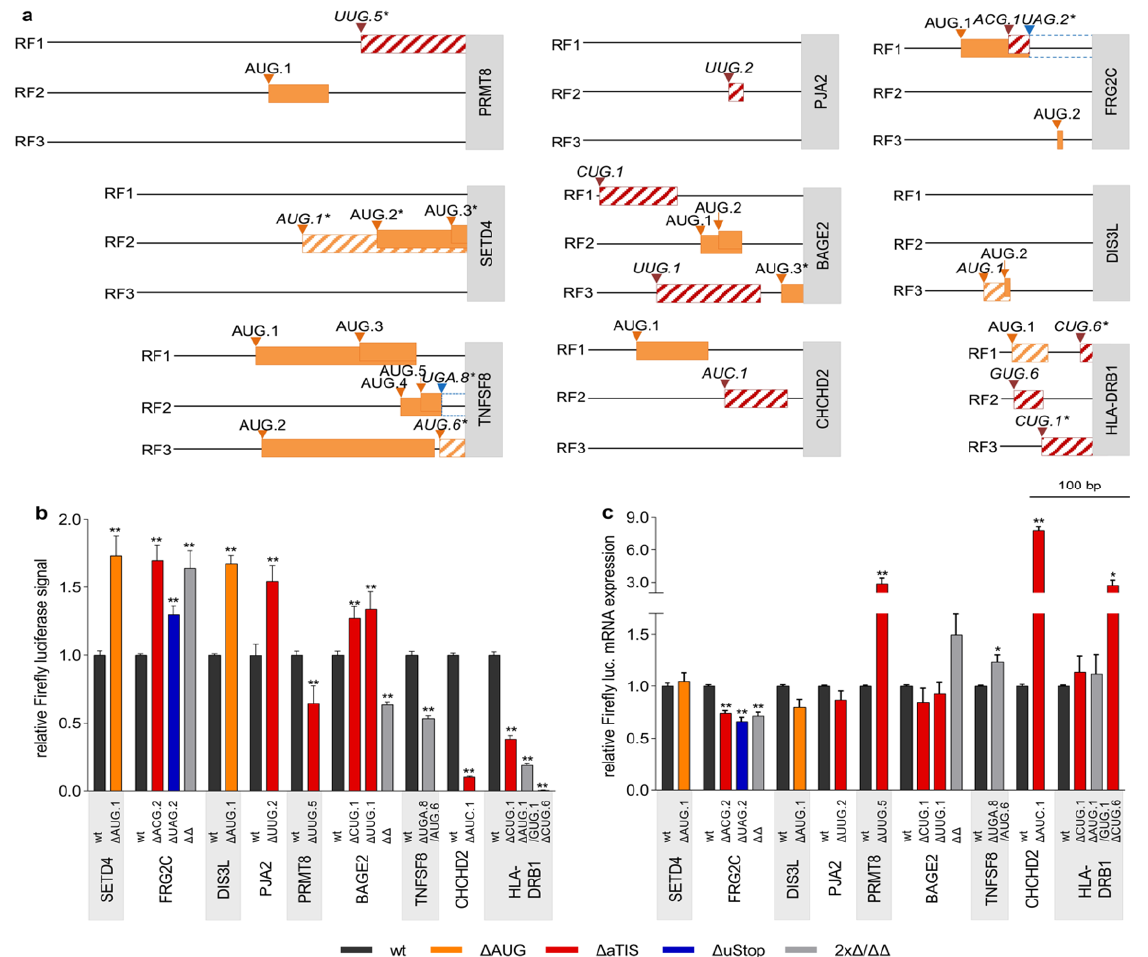
Figure 3. Naturally occurring cancer-associated genetic uORF variants alter downstream translational regulation. ( a ) Schematic representation of indicated TLSs, displaying the position, length and reading frame (RF, black lines) of uAUG (boxes with oblique orange lines) and aTIS (boxes with oblique red lines) uORFs affected by recurrent somatic SNVs. The start of the CDS is depicted by grey boxes containing the respective gene symbol. The lengthening of uORFs due to uStop deleting SNVs is indicated by blue hatched boxes. All AUG uORFs of respective TLSs that were not affected by genetic variation are indicated by filled orange boxes. * = original/new uStop codon is downstream of the CDS start site. ( b ) Bar graph showing the relative Firefly luciferase signals in the presence of wt TLSs (dark grey bars) and the respective ∆ uAUG (orange bars), ∆ aTIS (red bars), ∆ uStop (blue bars) containing TLSs, normalized to Renilla luciferase signals. Results for TLSs with SNVs affecting two uORF-associated codons simultaneously and double mutant TLSs with both previously indicated SNVs ( ∆∆ ) are represented by light grey bars. ( c ) Bar graph indicating relative Firefly luciferase mRNA levels of wt uORF and ∆ uORF TLSs. For each construct, Firefly luciferase mRNA levels were normalized to Renilla luciferase mRNA levels. Each bar represents data of ≥ 3 independent experiments, statistical analysis was performed using non-parametric Mann–Whitney-U-Test, * indicates p < 0.05 and ** p < 0.01.